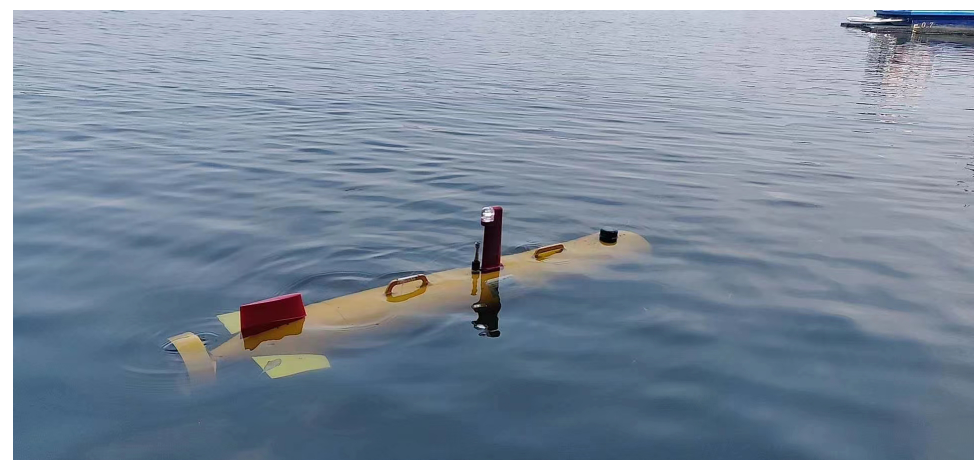
Figure 8. Sailfish-210 during the